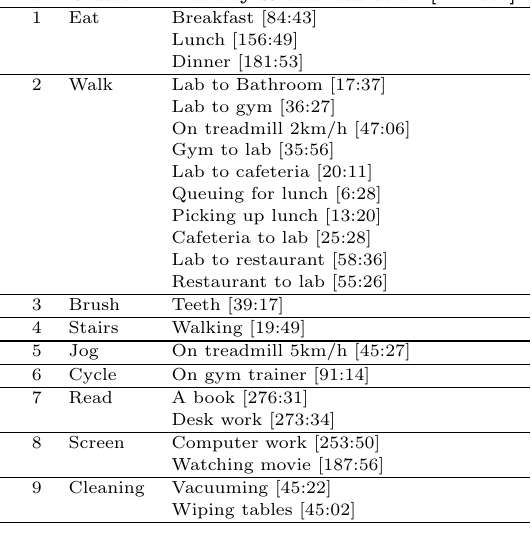
Table 2: Motion features calculated for a vector of data samples w with the window size n with elements 1 . . . N , where w i is the i-th sample in the window. w (cid:48) and w (cid:48)(cid:48) are the first and second derivative of w determined between two neighbouring samples. zcr() denotes the number of zero crossings.